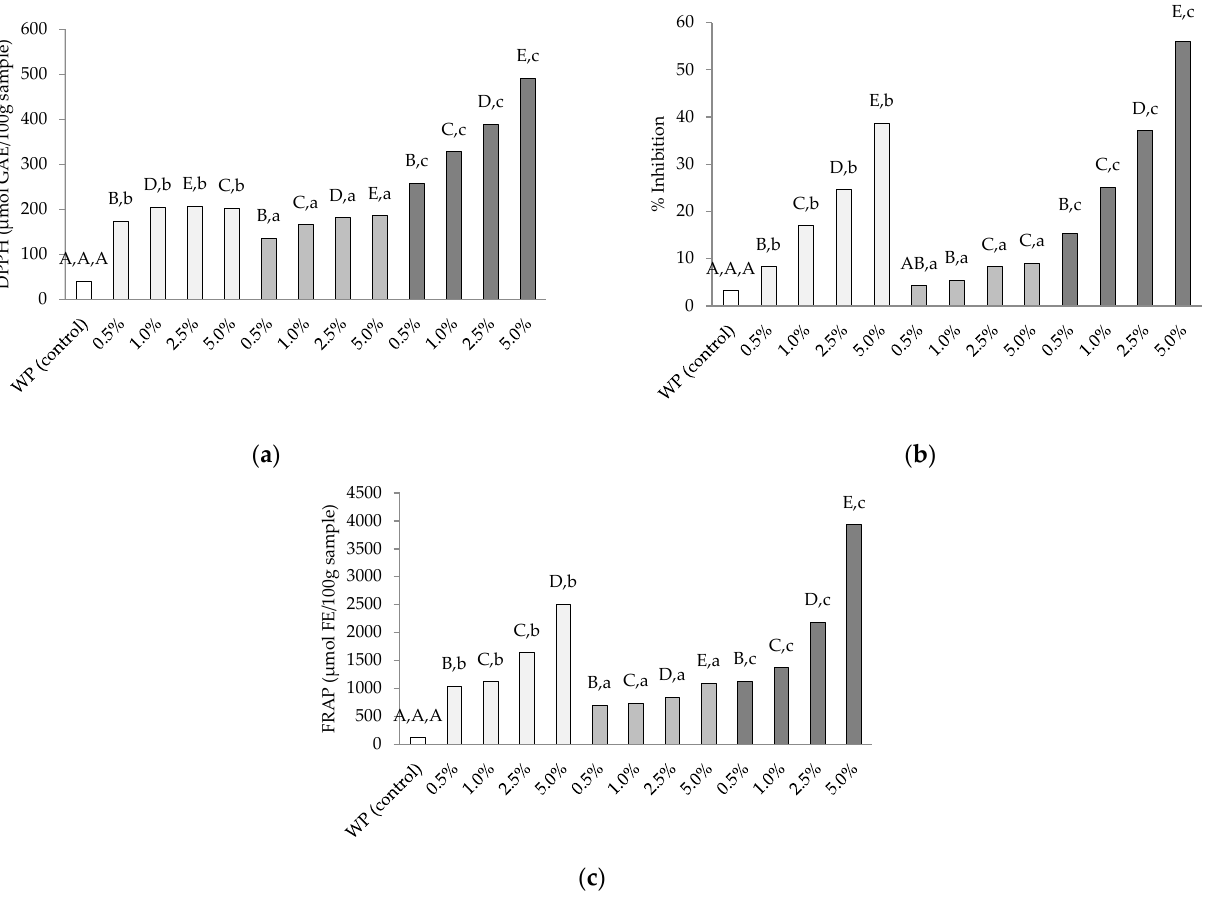
Figure 6. Antioxidant activities (DPPH ( a ), ABTS ( b ), and FRAP ( c )) of whey and whey modified with phenolic compounds (OGA, OFA, and OTA) at concentrations of 0.5, 1.0, 2.5, and 5.0% based on protein content. Different letters in the same concentration of oxidized phenolic compounds indicate significant differences. Different capital letters in the same type of oxidized phenolic compounds and control indicate significant differences.